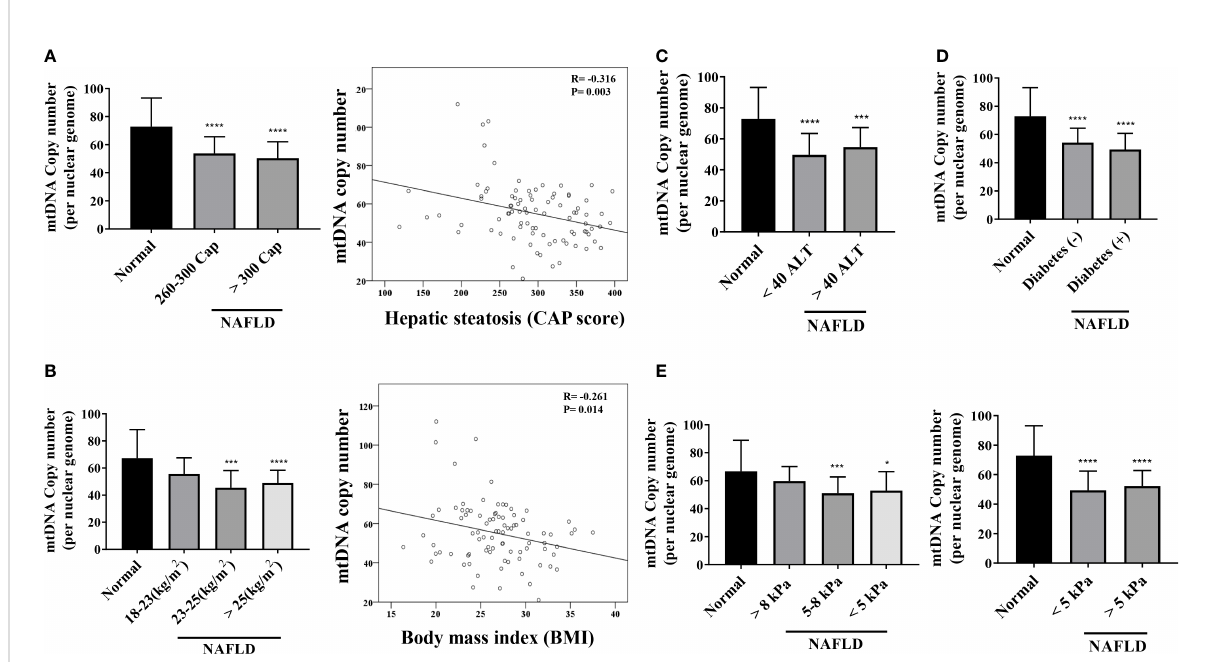
FIGURE 4 Mitochondrial copy number of peripheral mononuclear cells in NAFLD. (A) Results of mitochondrial DNA (mtDNA) copy number based on the hepatic steatosis standard. *P < .0001 compared with the control. There is a negative correlation between the mtDNA copy number and hepatic steatosis (R = -0.316, P = .003). (B) Results of mtDNA copy number based on BMI (**P=0.001 – 0.01; ****P < 0.0001). mtDNA copy number has a negative correlation with BMI (R = -0.261, P = .014). (C – E) mtDNA copy number results based on ALT, diabetes, and kPa standards (*P=0.01 – 0.05; ***P=0.001; ****P <